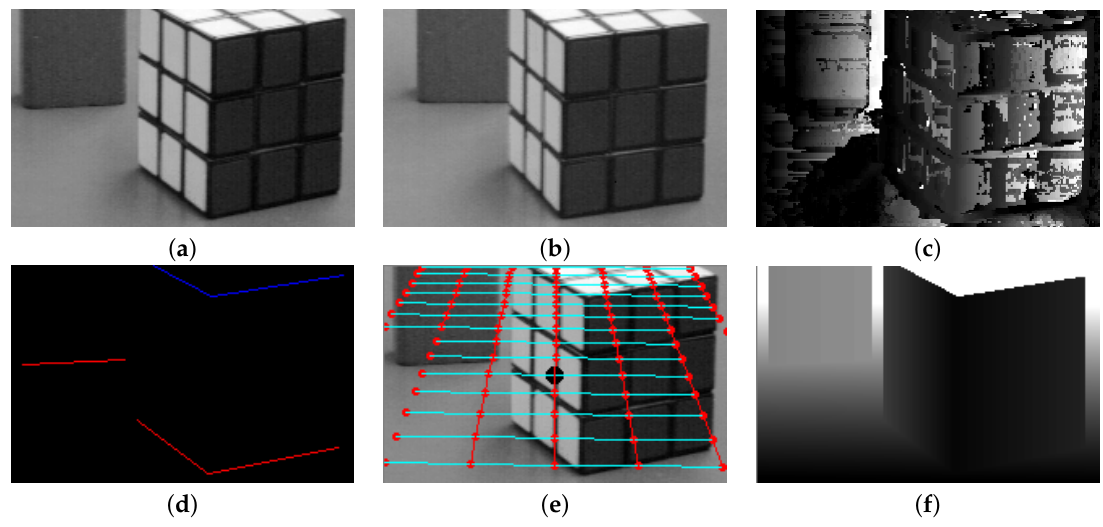
Figure 9. Comparison of depth estimation results using the stereo-based and the proposed methods: ( a ) the left stereo image; ( b ) the right stereo image; ( c ) estimated depth map using the stereo matching-based method; ( d ) guide lines of the left image; ( e ) estimated ground plane of the left image; and ( f ) estimated depth map of the left image using the proposed method.